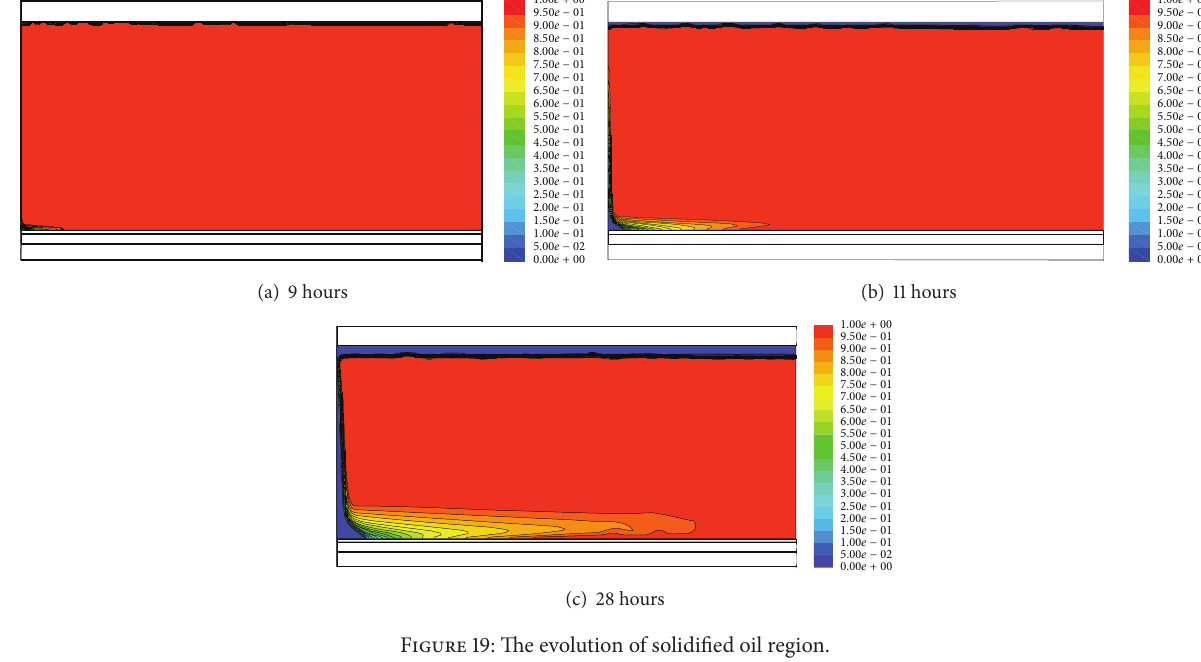
Figure 19: The evolution of solidified oil region.